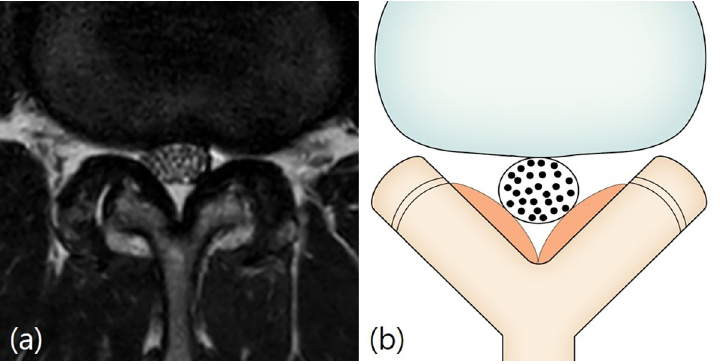
Fig 2. Schizas classification. Grade B (moderate stenosis). Fig 2A and 2B: A 59-year-old man with pain in both buttocks and both lower extremities. T2-weighted axial magnetic resonance image at L2/3 disc level shows the rootlets occupying the entire dural sac, but rootlets can still be